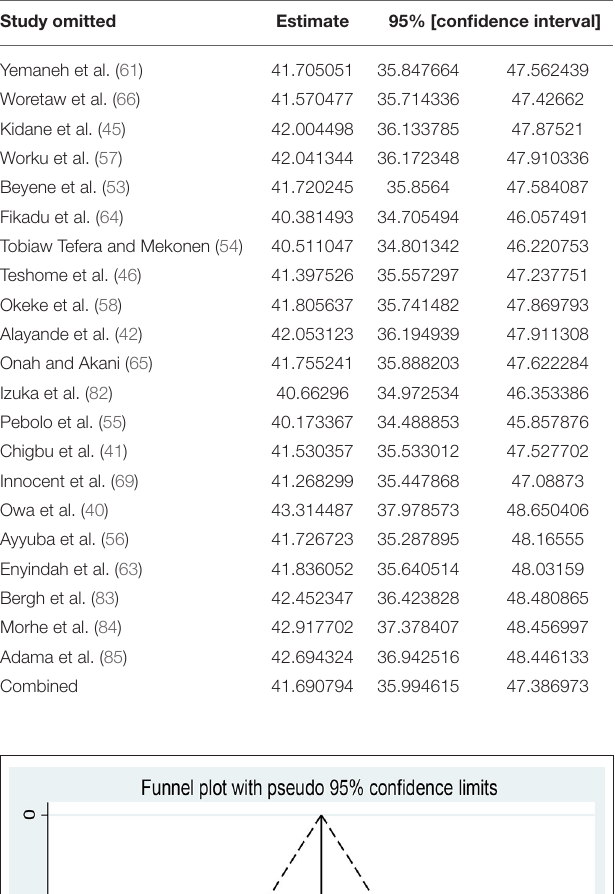
TABLE 3 | Sensitivity analysis of pooled prevalence with each study removed one by one.